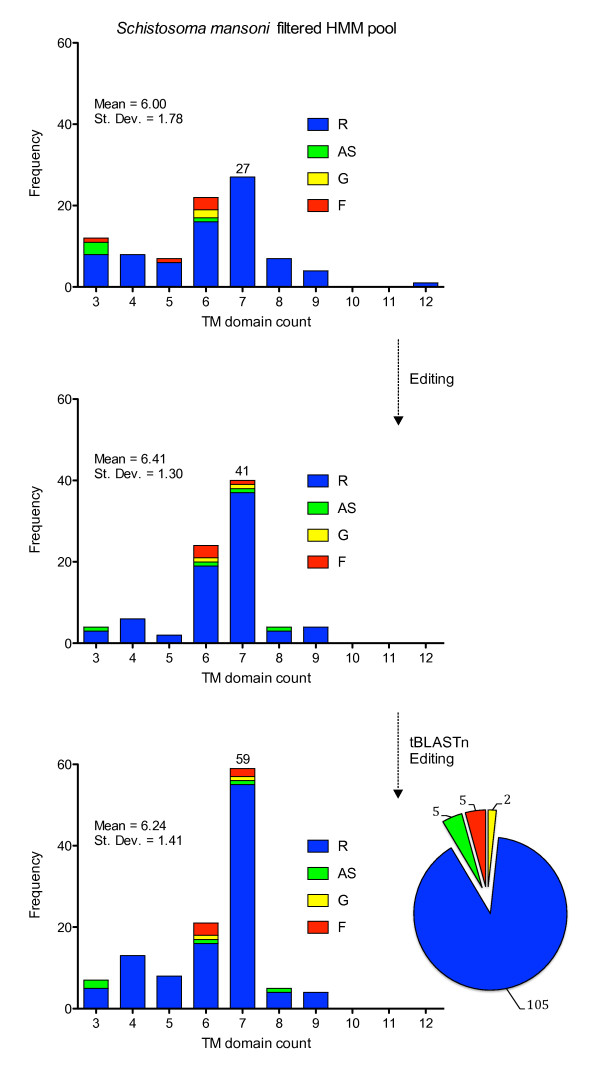
Manual curation and expansion of Schistosoma mansoni GRAFS GPCRs. The transmembrane distributions for the filtered S. mansoni HMM pool is shown before (top) and after (middle) manual editing of the underlying gene models, as predicted by HMMTOP. The number of GPCRs with a predicted intact 7TM domain increases from 27 to 41, coupled with a significant contraction of the distribution spread. The mean TM count shifts from 6.00 to 6.41, which equates to the identification and addition of roughly 42 missing TM domains during the first round of curation. Homology-bases searches against the genome assembly increased the putative 7TM receptor count to 59 (bottom). Receptors in the 8 and 9 TM bin can be considered full-length for our purposes, as the erroneously-predicted additional TM domains can be excised for phylogenetic analysis. Inclusion of these receptors brings the total putative full-length (7TM) receptor tally to 68 (of 117 total sequences).